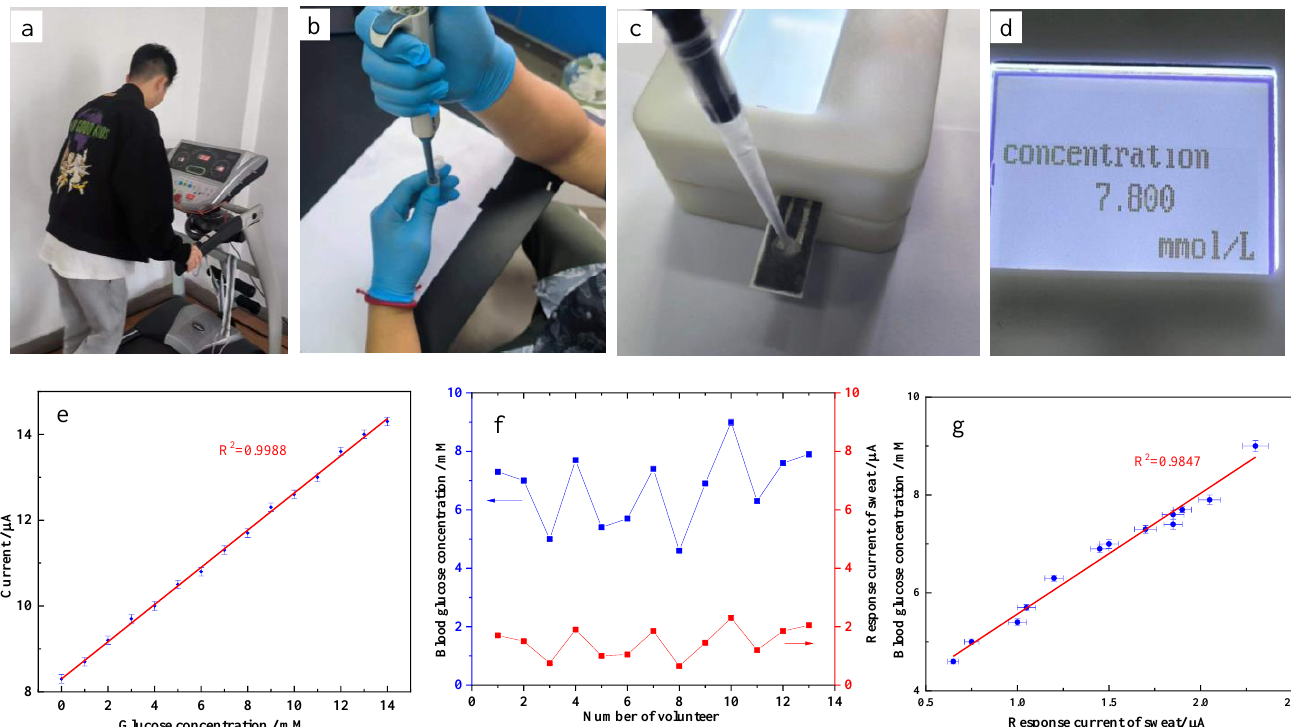
Figure 6. The experiments of sweat sampling and glucose detection. ( a ): exercise for sweat sampling.